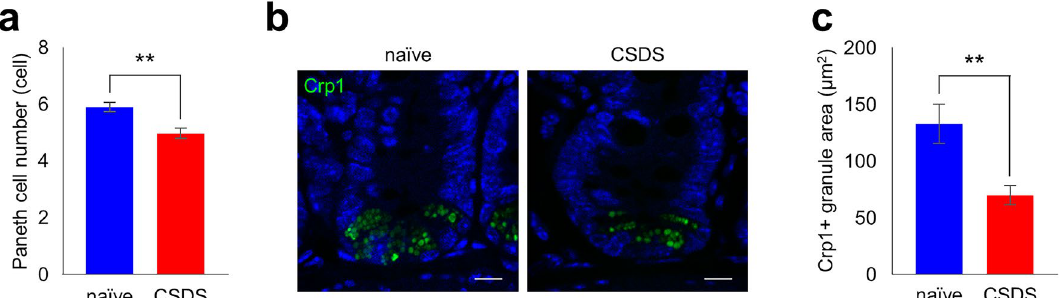
Figure 2. Decrease of Paneth cell number and cryptdin-1 expression in CSDS model. ( a ) Paneth cell number per crypt. ( b ) Representative confocal images of Crp1 (green) with DAPI (blue) of crypt sections. Scale bars indicate 10 µm. ( c ) Crp1 positive granule area per crypt. The data of a, c were shown as mean ± SE of six independent experiments in each group. Mann–Whitney U tests were used to compare the data. ** P <